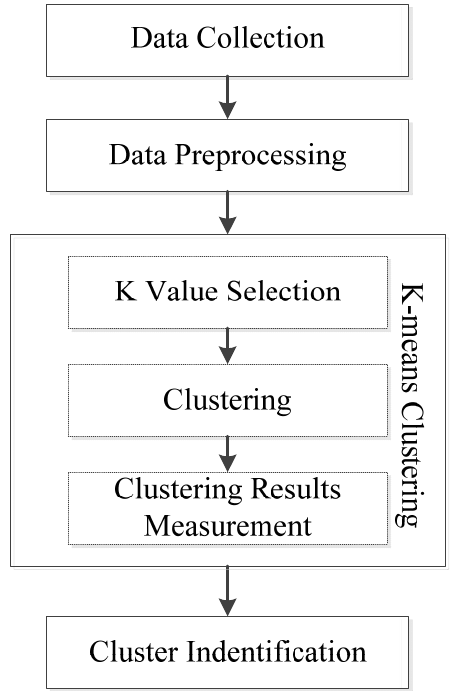
Figure 2. Flowchart for pattern recognition of different refrigerator operation